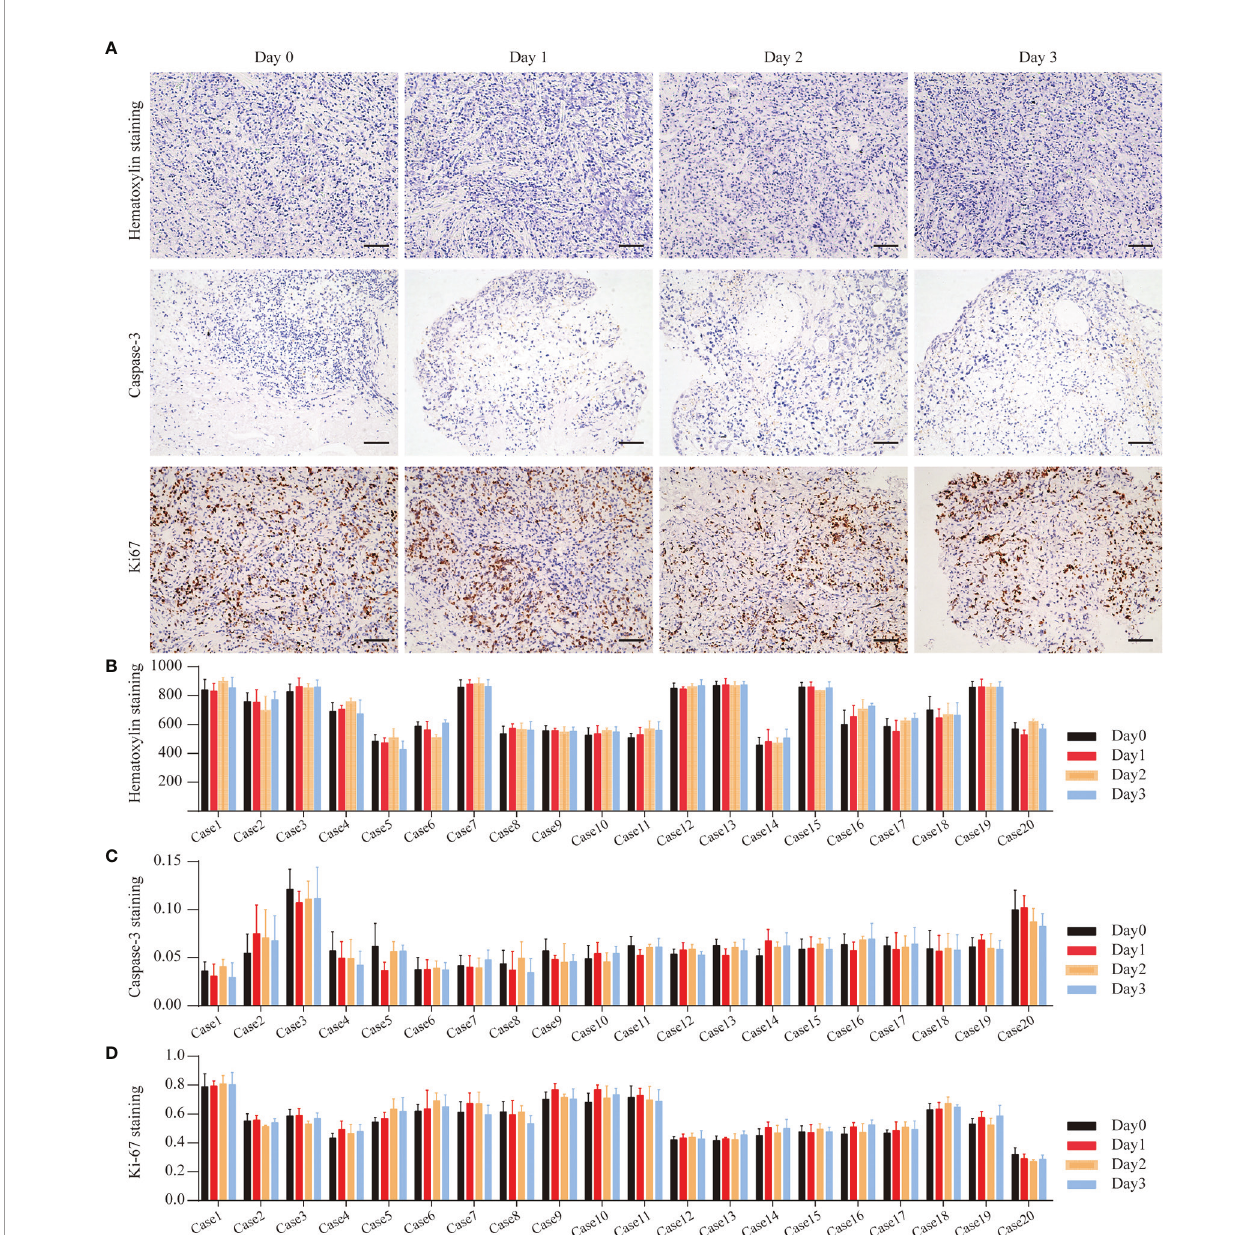
FIGURE 3 | GC Cell Proliferation and Apoptosis during the culture. (A) Hematoxylin staining of Case13 before and after 3 days of culture. Cas3 staining of Case15 before and after 3 days of culture. Ki67 staining of Case16 before and after 3 days of culture, scale bar, 100 m m. (B) Quantitative analysis of hematoxylin in 20 cases of GC tissues. (C) Quantitative analysis of Cas3 in 20 cases of GC tissues. (D) Quantitative analysis of Ki67 in 20 cases of GC